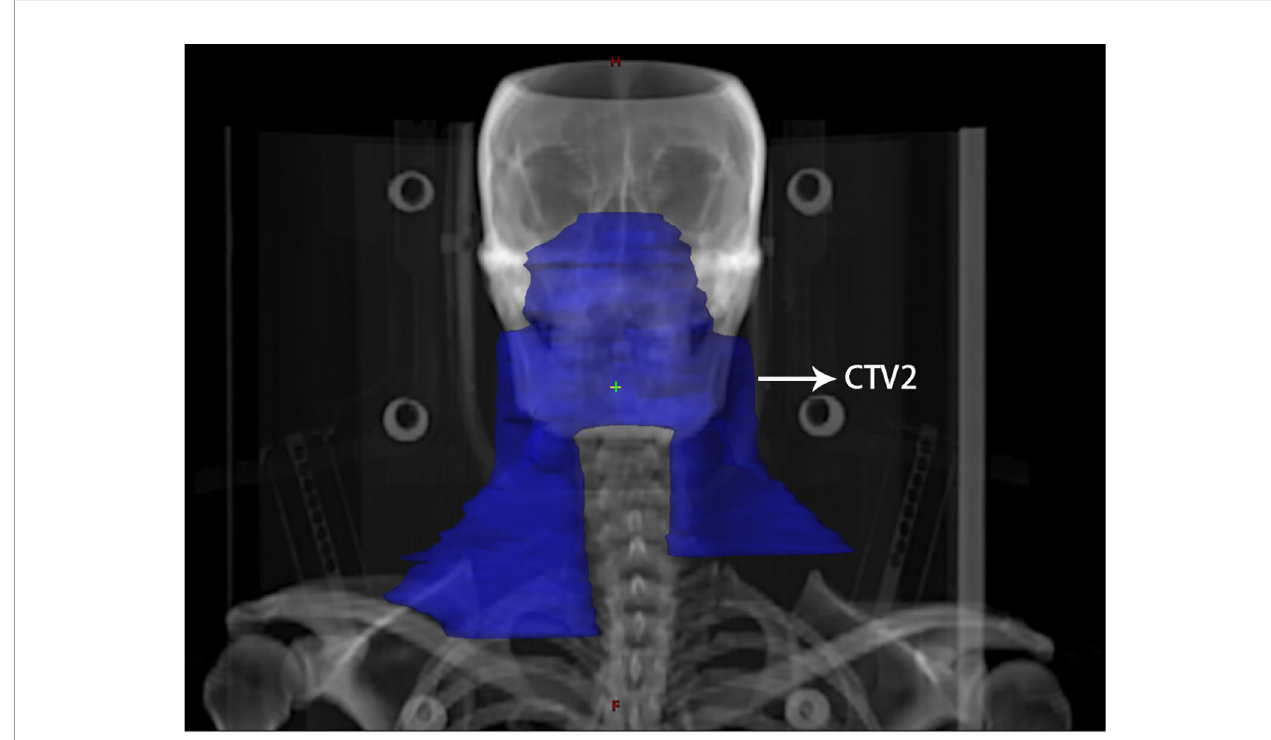
FIGURE 1 | An illustration of contralateral lower neck sparing radiotherapy for a patient with stage N1 nasopharyngeal carcinoma. The blue area indicates the extent of elective neck irradiation, including the bilateral upper neck as well as the ipsilateral lower neck, excluding the lower neck on the contralateral